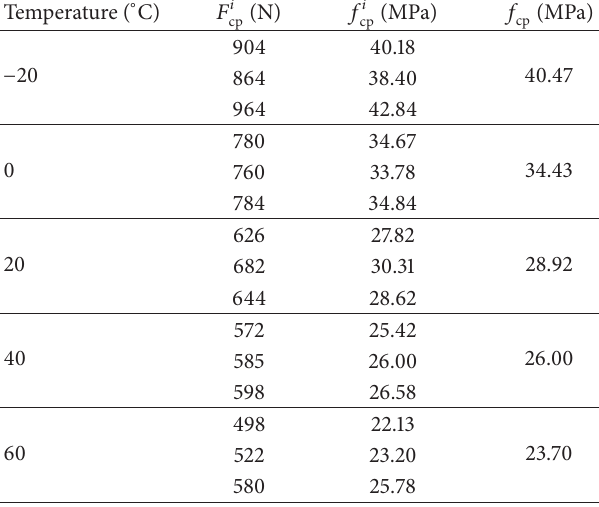
Table 3: Results of prism compressive strength for concrete under different